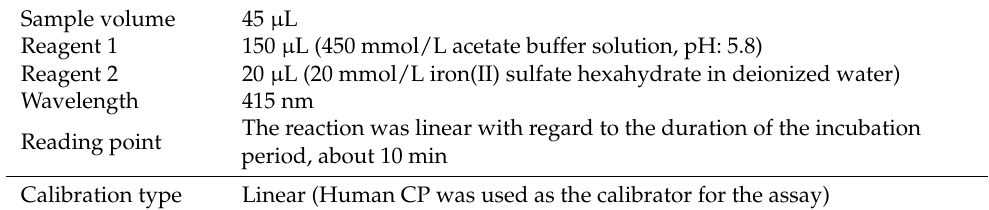
Table 1. The procedure of the assay for fully automatic spectrophotometric